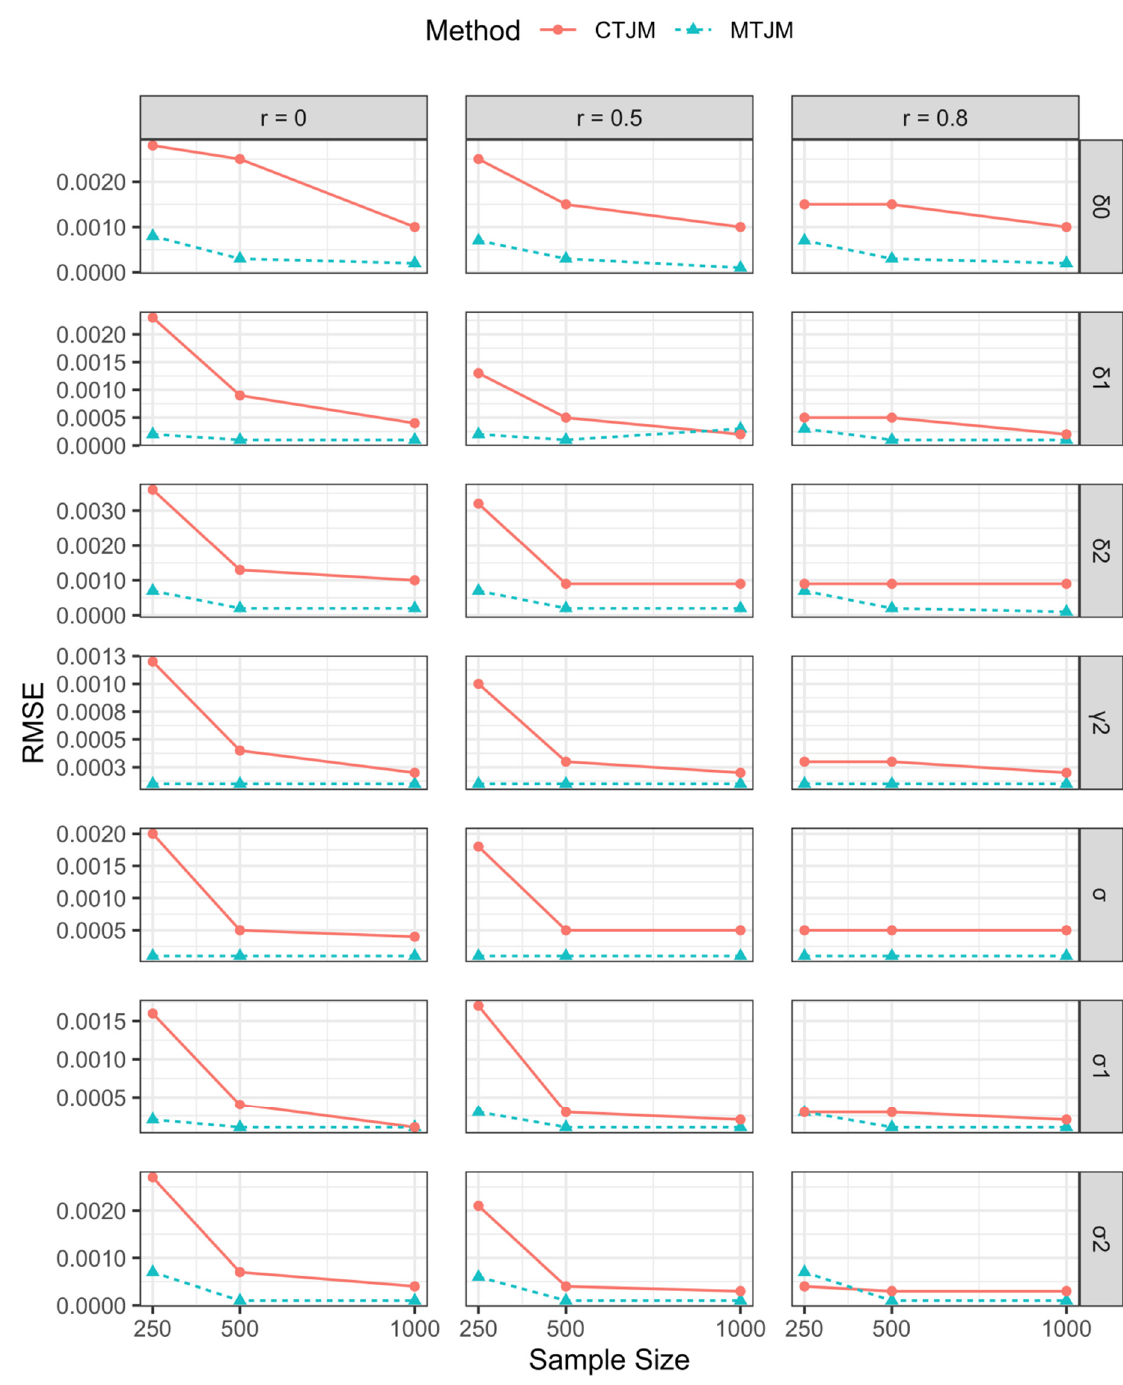
Figure 1. RMSEs for parameter estimates obtained from simulation study for the marginalized two-part joint model (MTJM) and conventional two-part joint model (CTJM).